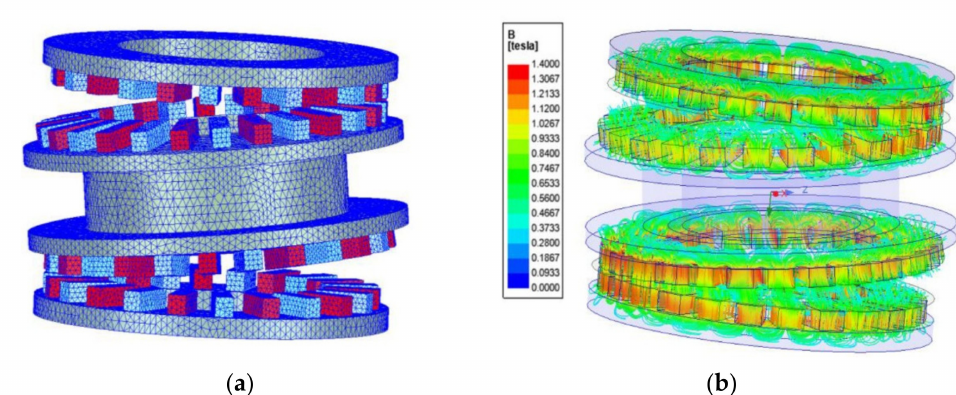
Figure 5. Details of the numerical model: ( a ) applied finite element mesh (excluding the air region) and ( b ) magnetic field line distribution at selected positions of the gear elements for a precession angle equal to 6 ◦ and a gear ratio equal to 1/144.